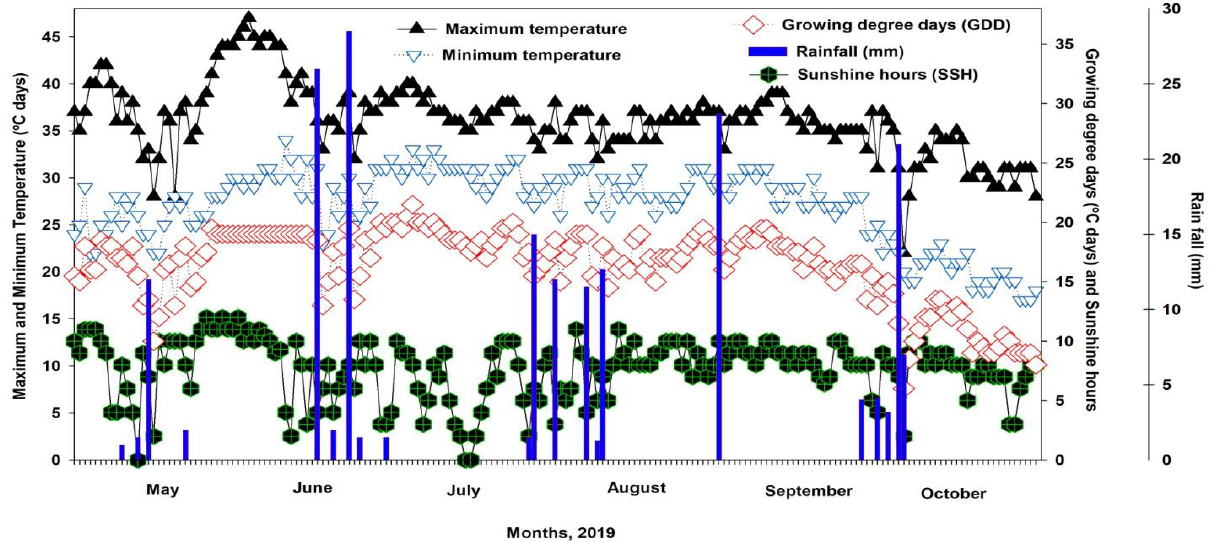
Figure 1. Data of daily weather variables (maximum and minimum temperature, sunshine hours, growing degree days (cotton), and rainfall) during crop growing season in 2019.